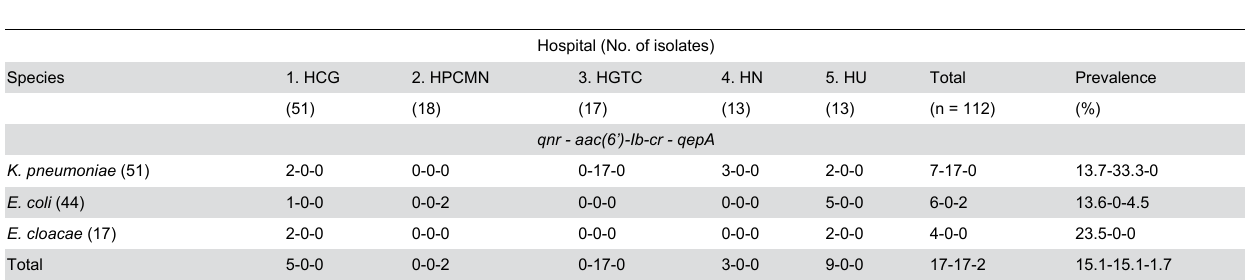
Table 1. PMQR gene prevalence among ESBL-producing Enterobacteriaceae pediatric isolates.